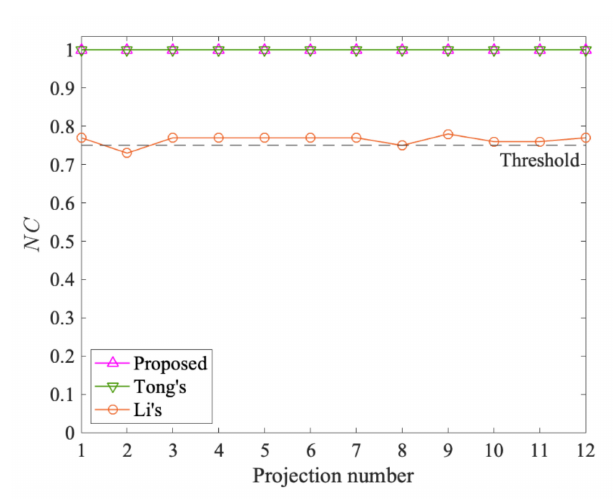
Figure 7. The results of Railroad.